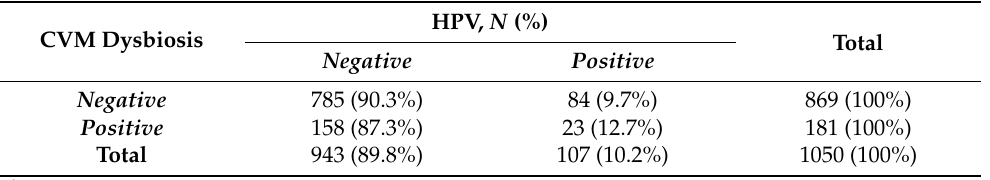
Table 6. Correlation of a positive result for cervico-vaginal microbiota (CVM) dysbiosis (imbalance) with HR-HPV positive test result ( N = 1050).